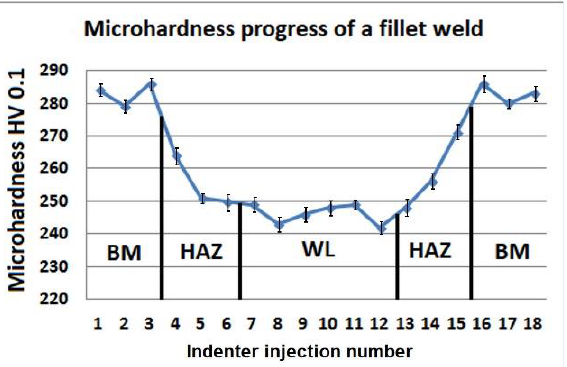
Figure 20. The course of microhardness of the corner weld of a crushing hammer (BM: base material, HAZ: heat-affected zone, WL: weld).